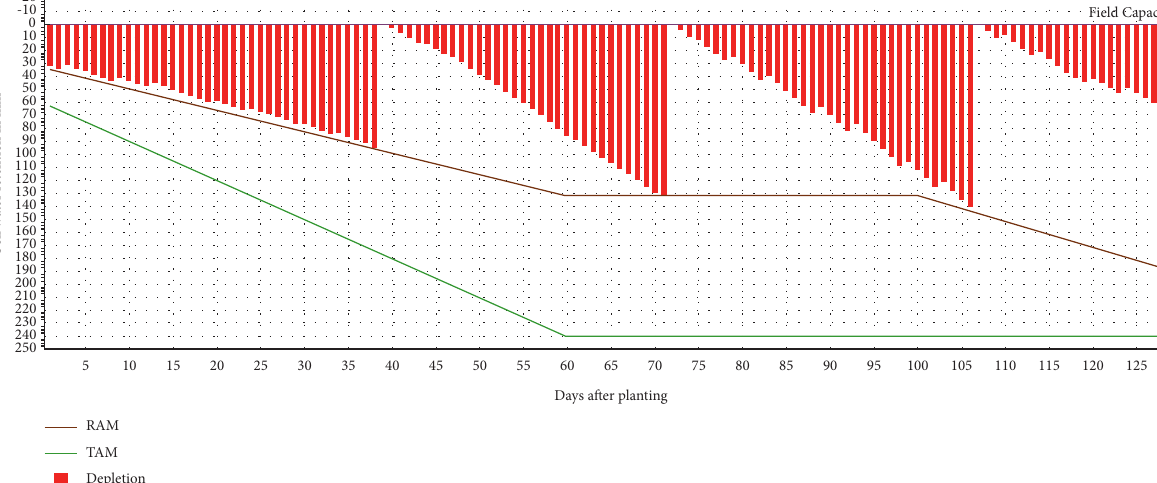
Figure 4: Color reveals the wheat irrigation schedules showing RAM (brown line); TAM (green line); and water depletion (red vertical line pattern).